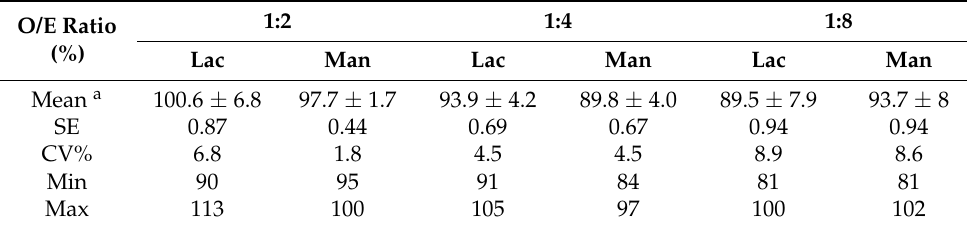
Table 1. Ratio of the observed-to-expected (O/E) recoveries of lactulose and mannitol using three spiked urine samples.